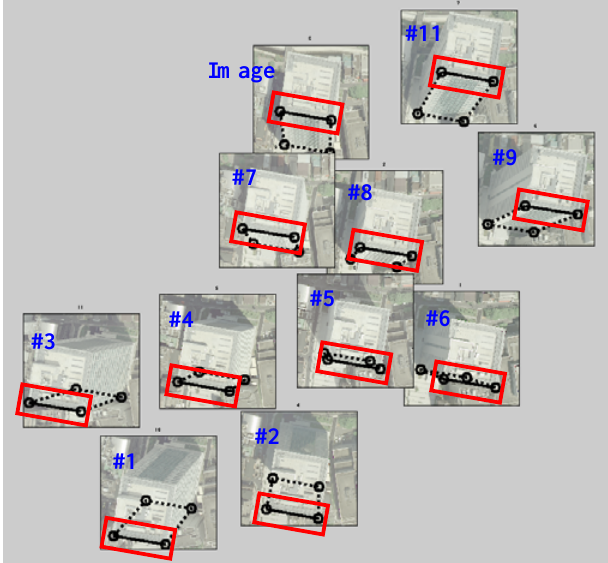
Figure 6. Generation of Voxel-Image